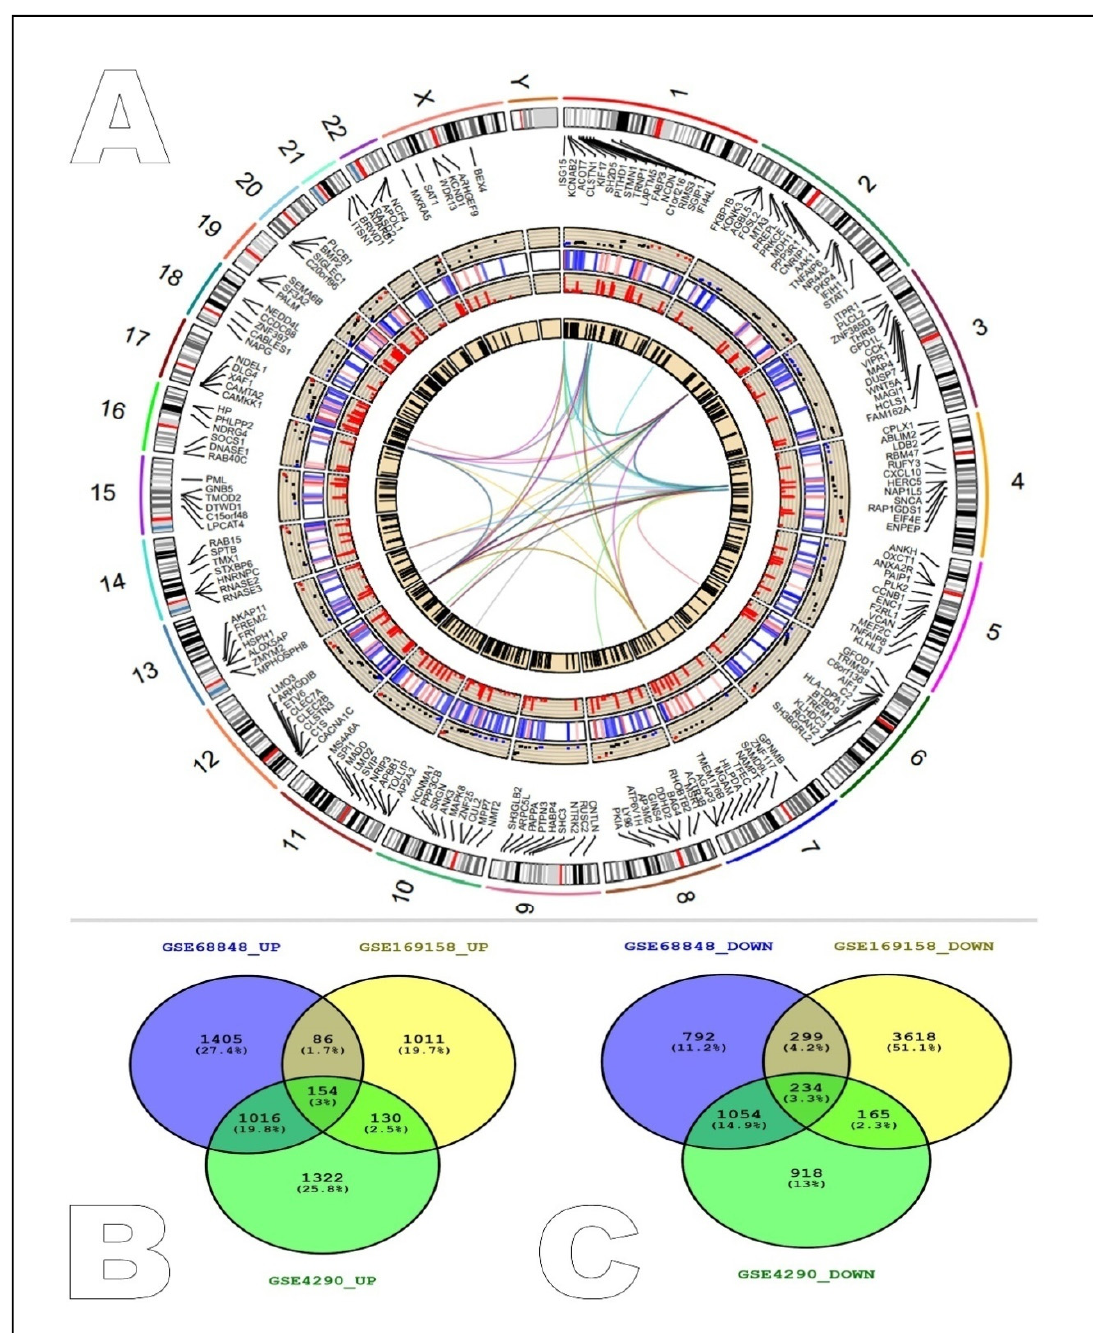
Figure 1. Distribution and status of shared differentially expressed genes and the intersection of yellow, black, and blue modules. ( A ) Circos layout: First circle: characterization of the human genome based on chromosome numbers. Second circle: locations of up-regulated genes (red), down-regulated (blue), and control genes (black) in all 24 chromosomes. Third circle: status of differentially expressed genes. Fourth circle: co-expression of up- and down-regulated genes. Fifth circle: only up-regulated genes. Core region: multiple color lines depicting the interaction between hub genes. ( B ) Shared up-regulated genes between studies. ( C ) Shared down-regulated genes between selected